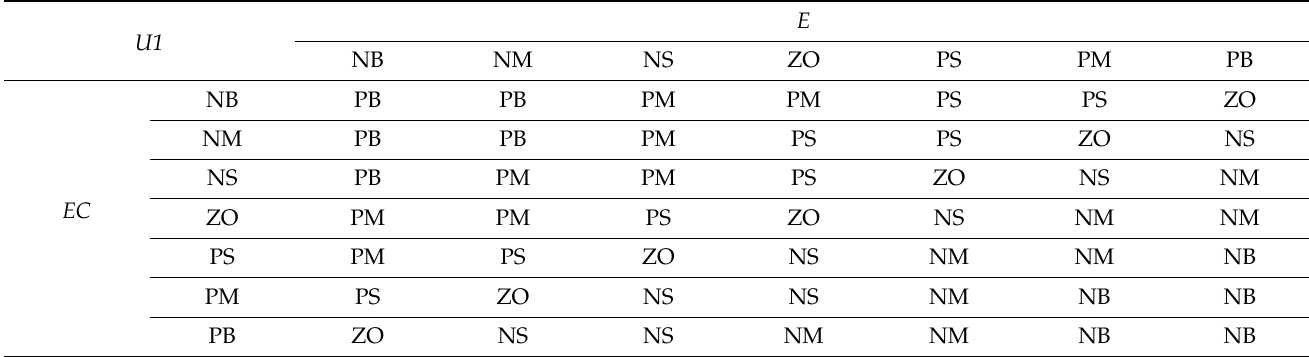
Table 1. Fuzzy rule base of U1 .